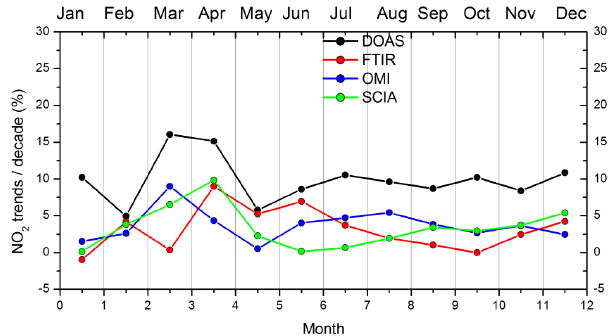
Figure 10. NO 2 monthly trends from year 2000 to